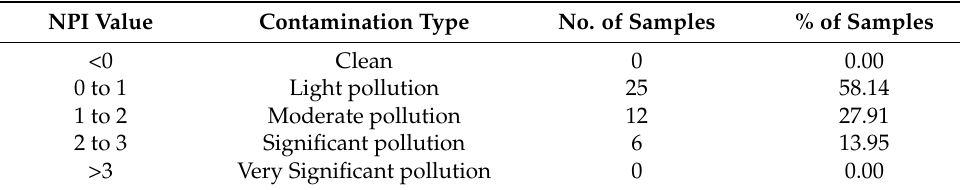
Figure 6. Nitrate contamination zones in the study area. Table 3. NPI classification of groundwater samples.